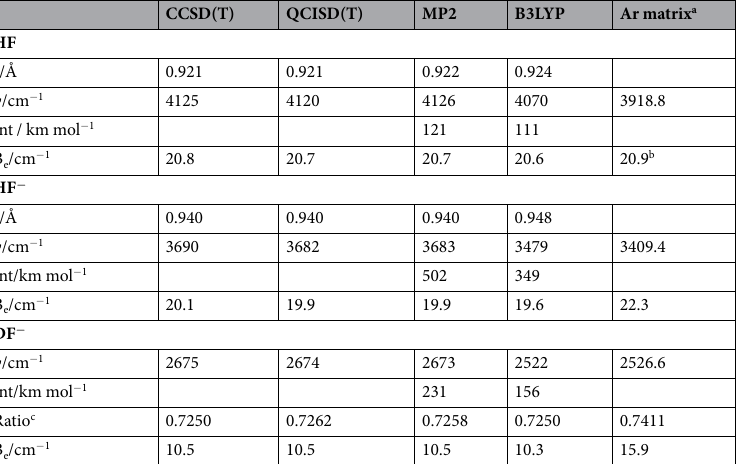
Table 1. Comparison of the predicted bond distance, harmonic vibrational wavenumbers, IR intensities, and rotational constants of HF, HF − , and DF − with experimental values. The basis set used for all calculations is Aug-cc-pVTZ. a Position of the Q band. b The rotational constant of gaseous HF is 20.9557 cm − 1 53 . c Defined as the ratio between the wavenumbers corresponding to the D-isotopic species and HF − .